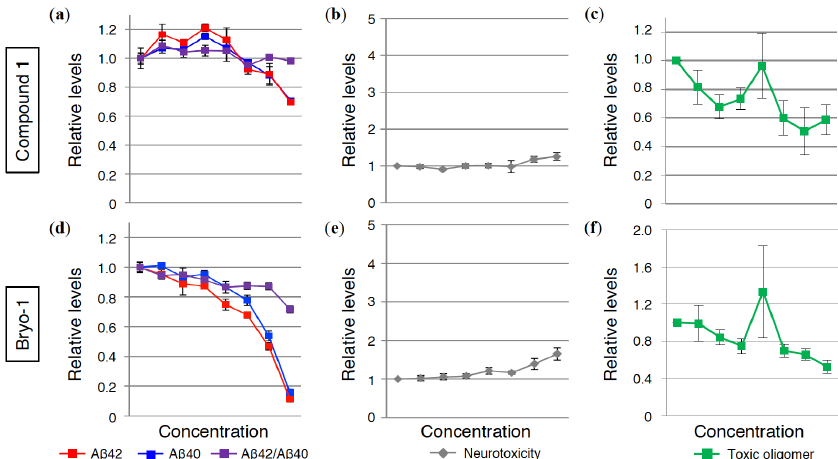
Figure 6. ( a , d ) Monomeric A β 42, A β 40, and A β 42/A β 40 in conditioned medium, ( b , e ) neurotoxicity, and ( c , f ) toxic A β 42 oligomers in lysate from human iPS-derived neurons treated with ( a , b , c ) 1 and ( d , e , f ) bryo-1 at the indicated concentration (0, 1, 3, 10, 30, 100, 300, and 1000 nM from left to right) for 24 h. The data are presented as mean ± SEM ( n =